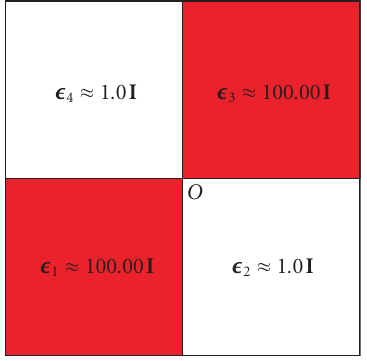
Figure 4.10 . Example 4.3: property distribution in Ω = ( − 1,1) × ( − 1,1).